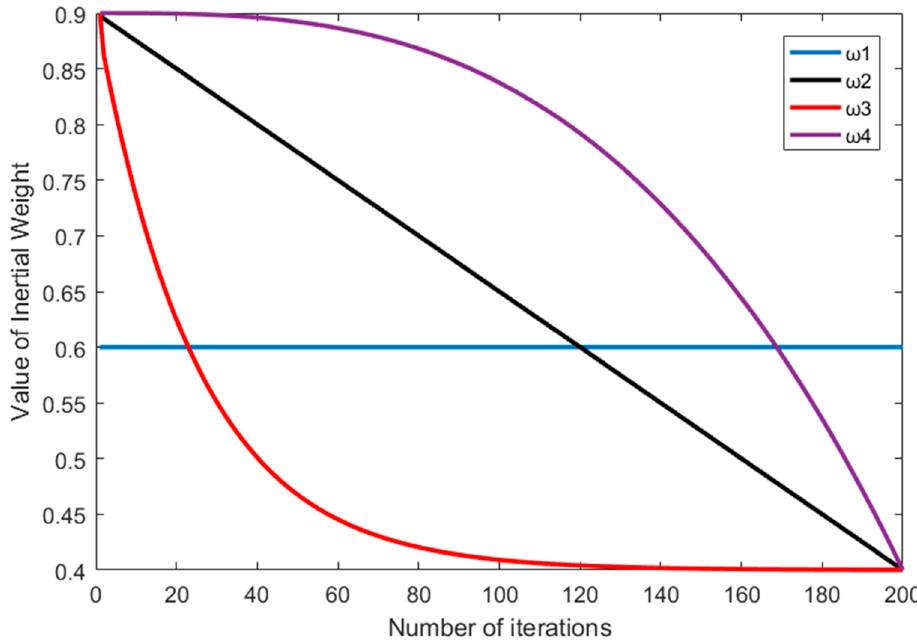
Figure 1. Variation of four inertial weights vs. iteration number. Figure 1. V ariation of four inertial weights vs. iteration number. Table 1. Parameter settings.